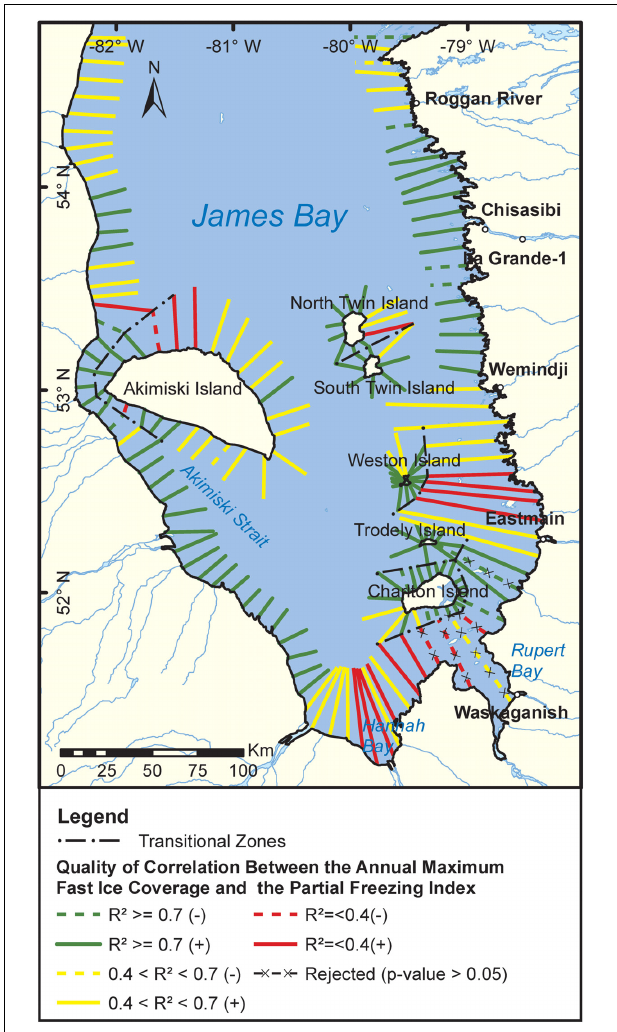
FIGURE 10 | Quality of the correlations between the annual maximum landfast ice coverage and the partial freezing index at